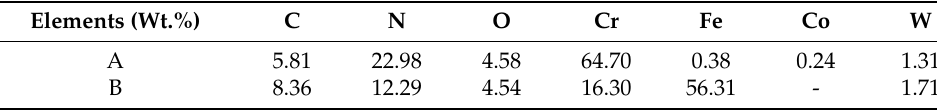
Figure 9. Wear and failure process of CrN-coated HSS under different normal forces. Table 6. EDS analysis of the points A and B in Figure 9. Elements